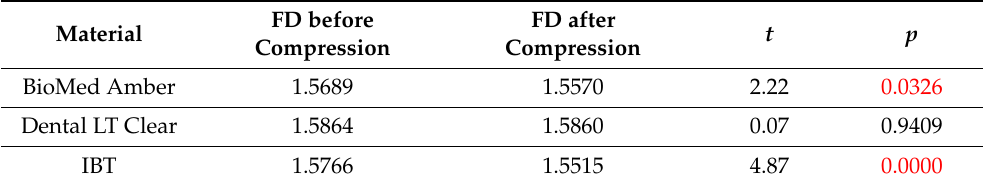
Table 13. Results of Student’s t -test for the comparison of FD values of the examined surfaces before and after the compression test ( t -value of Student’s t -test, p — p value; the statistical significance for p < 0.05 was presented in red).